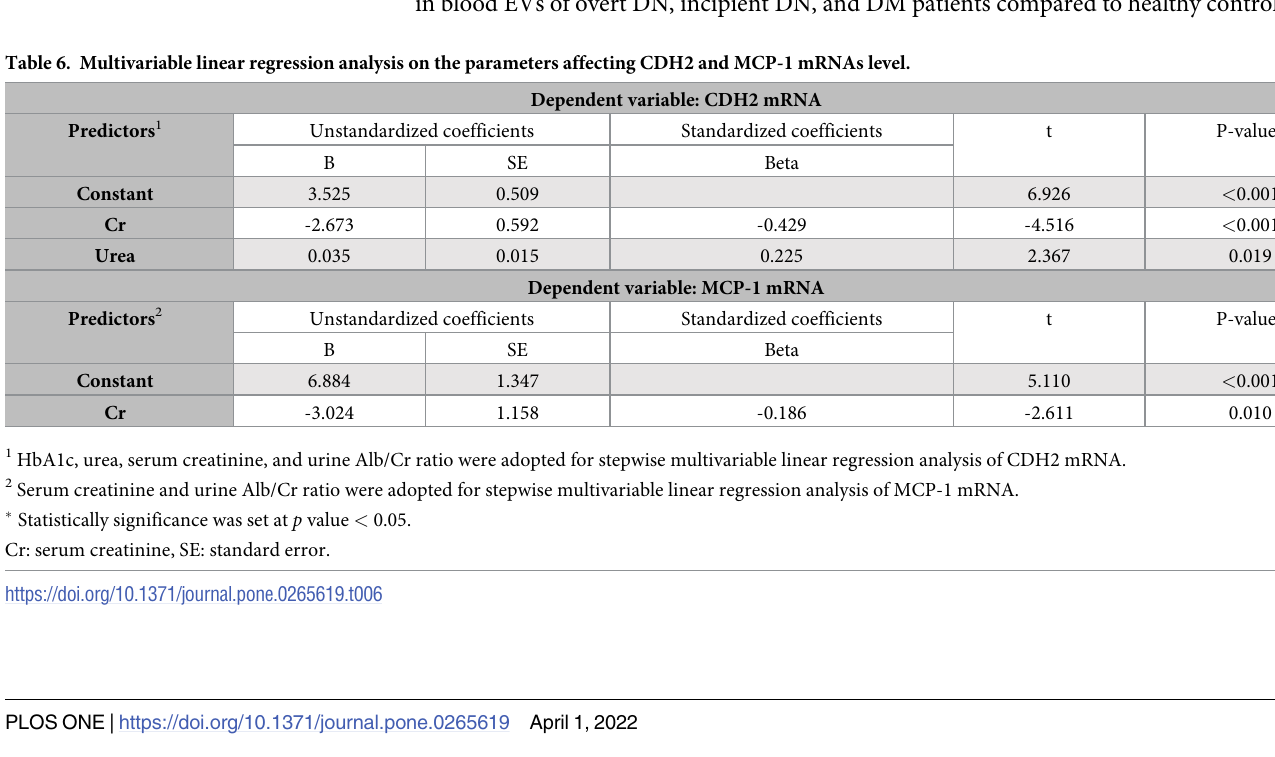
BMI: body mass index, FBS: fasting blood sugar, Cr: serum creatinine, eGFR: estimated glomerular filtration rate, Alb/Cr: urine albumin/ creatinine ratio, r = Spearman correlation coefficient, p = p -value.